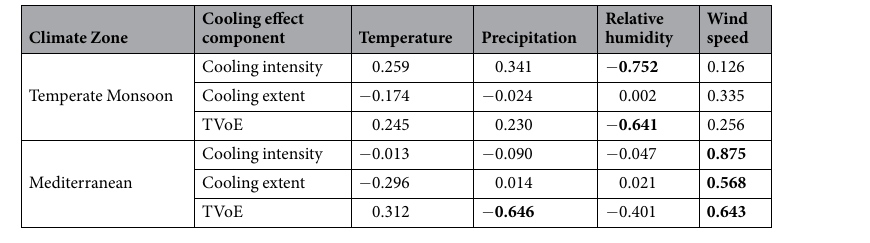
Table 4. The relationships between the cooling effect of Tree-covered UGV and the temperature, precipitation, relative humidity. The p-value test was not applied in this section due to the limited sample size (n = 8).